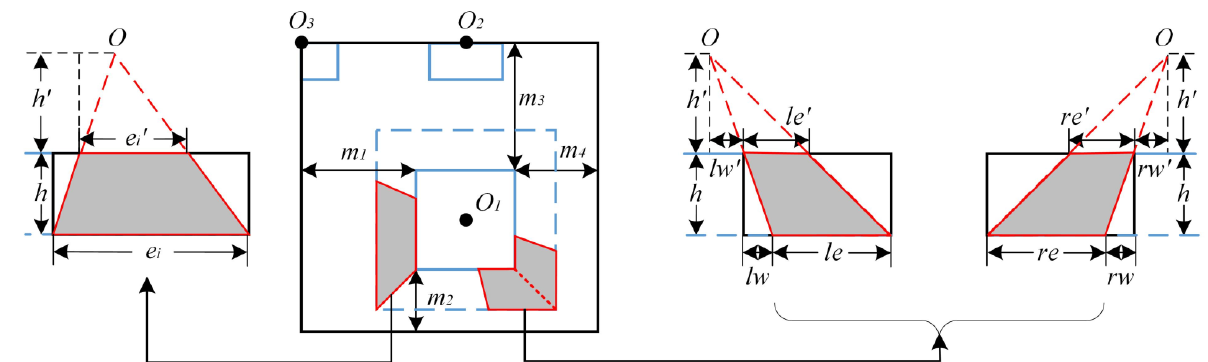
Figure 6. The details of function H in the Multi-level Data Decomposition